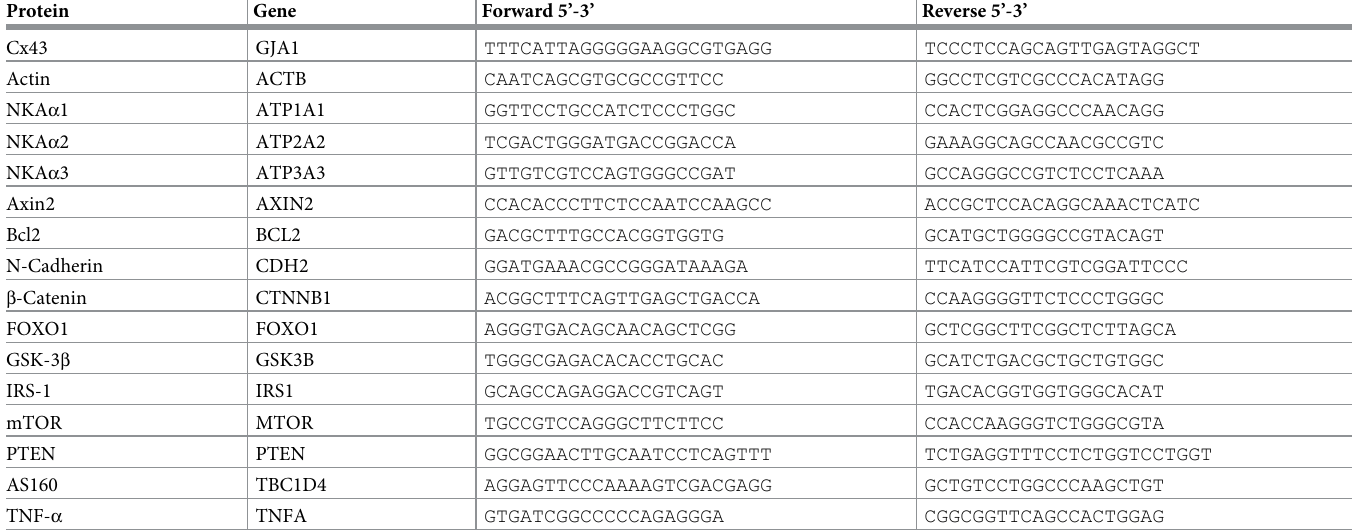
Table 1. Primers used in qPCR to amplify mRNA corresponding to genes of interest in this work. All the sequences are expressed in sense 5’-3’. Protein Gene Forward 5’-3’ Reverse